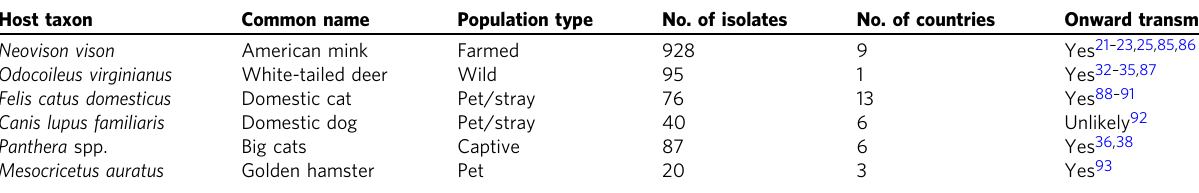
Table 1 Summary of high-quality animal-associated SARS-CoV-2 genomes.